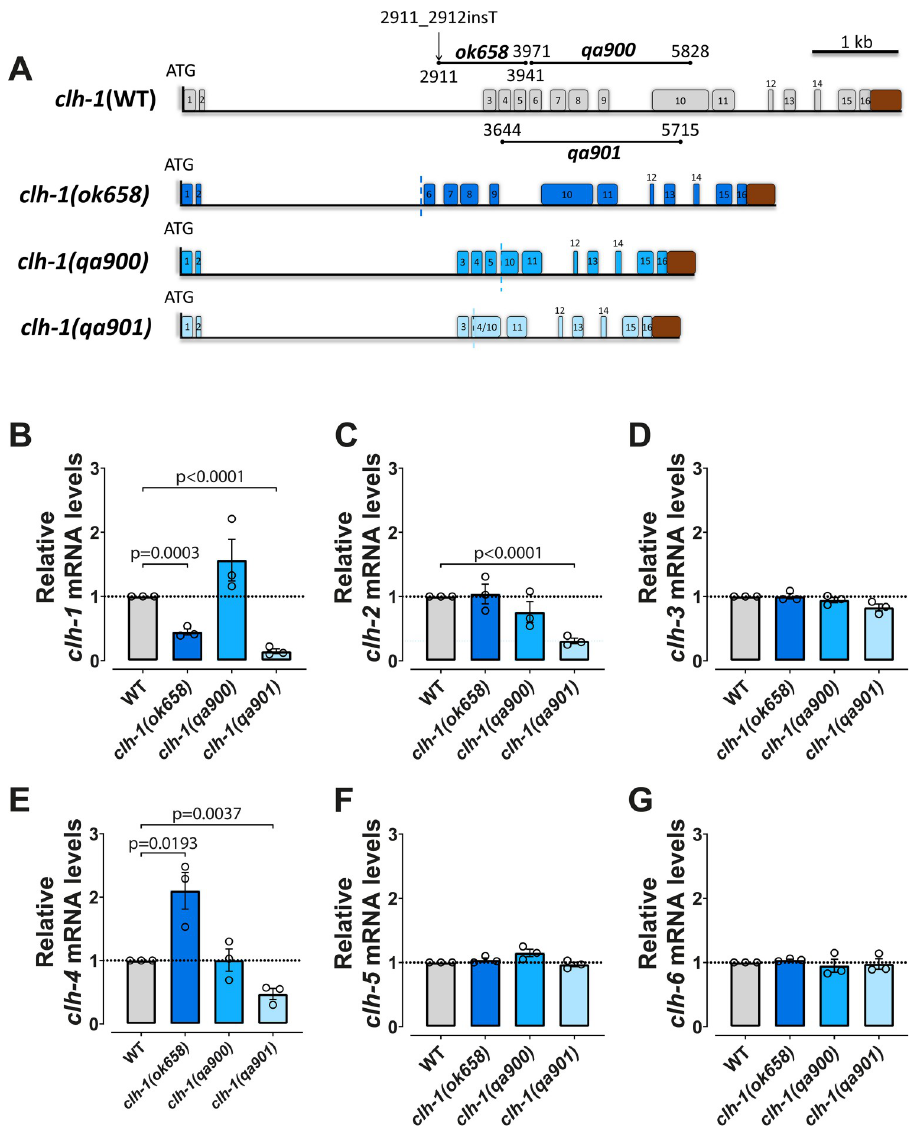
Fig 1. Different patterns of regulation of clh genes in three different clh-1 mutants. (A) Schematic representation of the clh-1 gene in WT and mutants. Each numbered box represents an exon, while lines are introns. The vertical line at the beginning of each gene represents the ATG start codon. The brown box represents the 3’UTR. The length and position of the deletions of each mutant and the insertion in the ok658 mutant are also shown in the wild type gene structure. The vertical dashed lines in each of the mutants represent the deletion position. (B-G) mRNA levels of the six clh genes in WT and mutant alleles. Data are expressed as mean ± SEM and normalized to WT levels, that were taken as 1. The pmp-3 mRNA levels were used as internal control. Three independent experiments with three technical replicates were performed. The horizontal dotted line in the graphs corresponds to the level in WT. All statistical differences are reported in the graphs (unpaired two-tailed t-test). Data used for this figure are reported in the S1